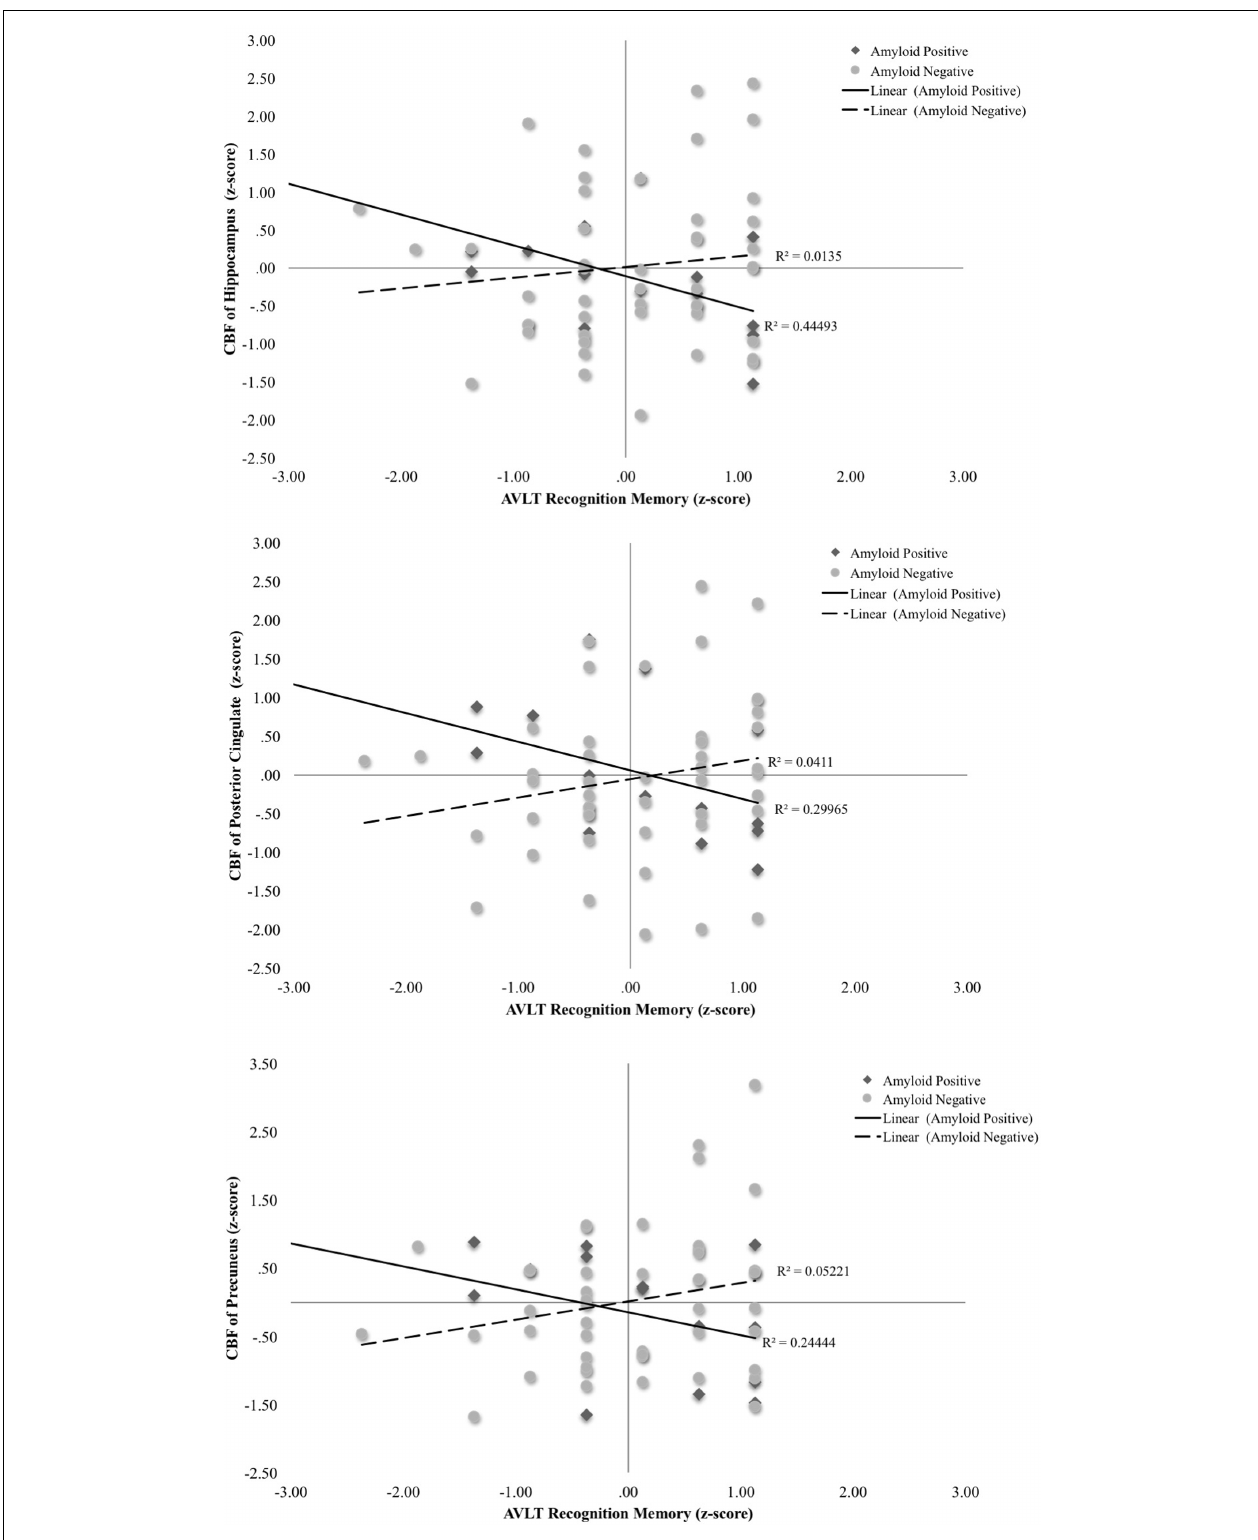
FIGURE 2 | Scatterplots of interaction of A β and cerebral blood flow on recognition memory (Rey Auditory Verbal Learning recognition hits-false positives raw z -score) for 3 a priori cortical regions of interest. A β positivity is based on threshold of based on the recommended threshold for cross-sectional florbetapir analyses of 1.11 using the whole cerebellum as the reference region. CBF is presented in standard deviation units. All interactions were statistically significant ( p < 0.05).